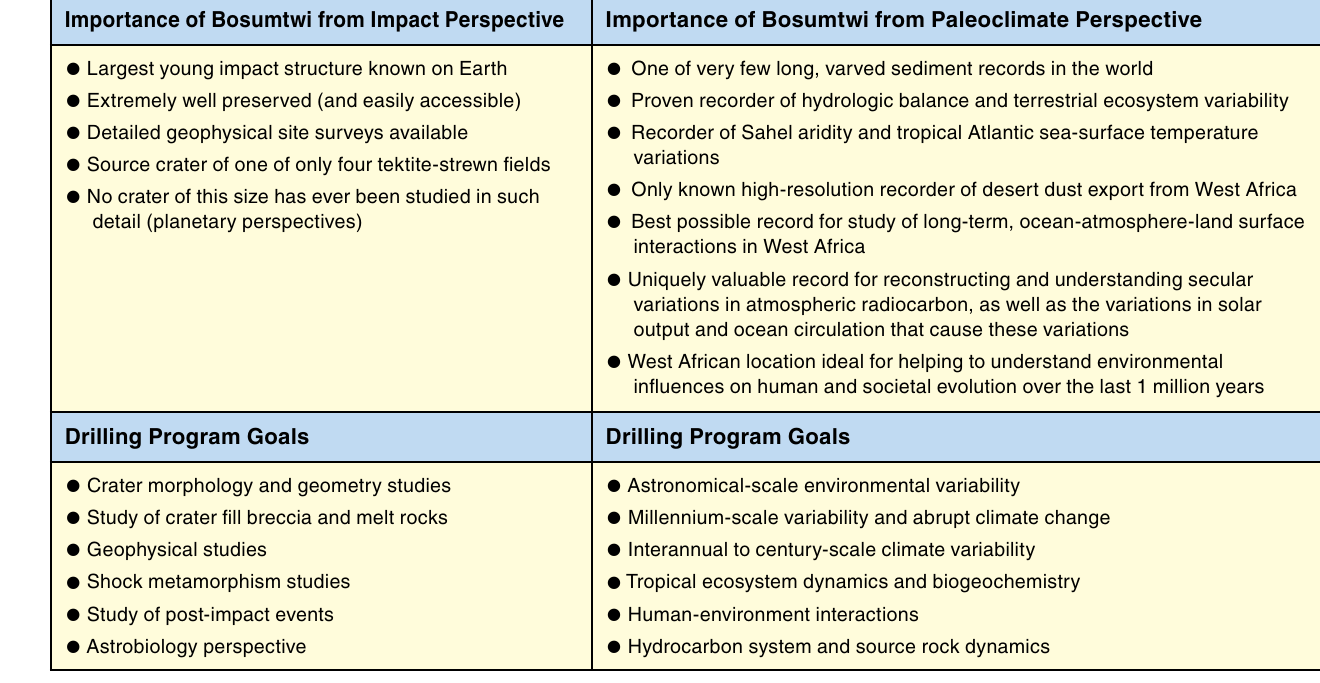
Table 1. Importance and Goals of the Bosumtwi Crater